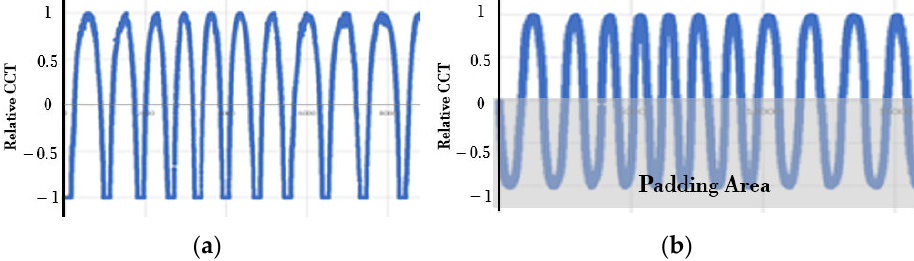
Figure 3. Color temperature training datasets (Anomaly ratio lower than 15%). ( a ) Training dataset—Original; ( b ) Training dataset—After implementing a padding.